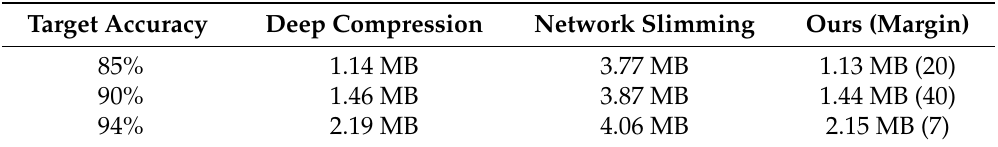
Table 3. The sizes of the minimized models in the corresponding accuracies derived from the proposed method and the individual cases of network slimming and deep compression for ResNet-110.